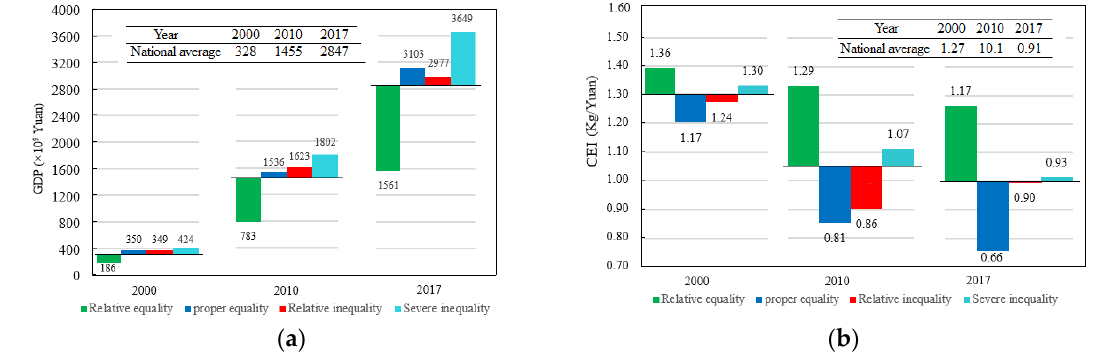
Figure 8. Comparison of regional to national (a). GDP and (b). CEI.